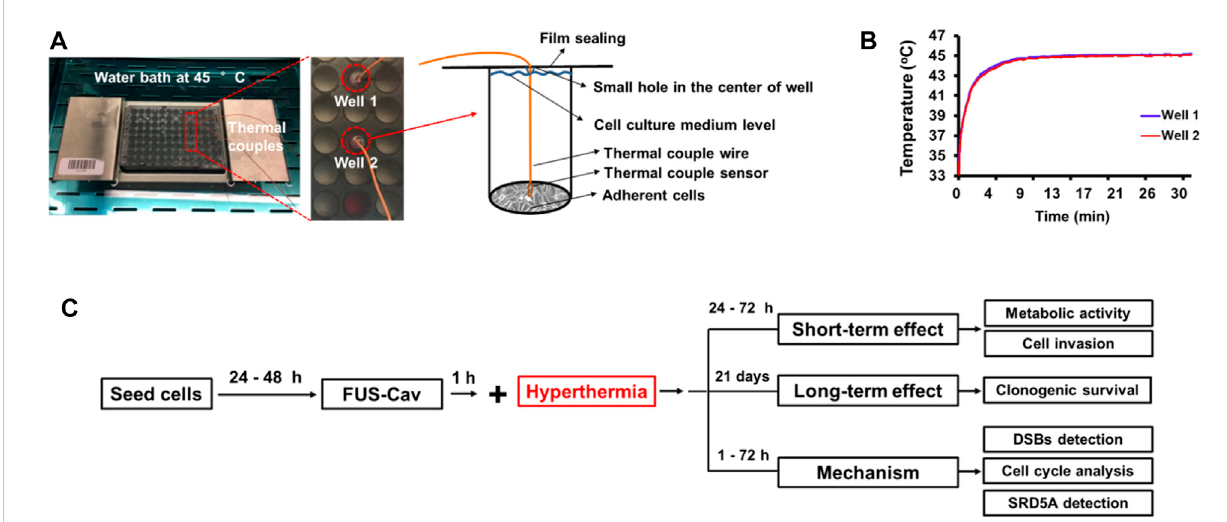
FIGURE 2 Experimental setup of water bath hyperthermia with 96-well plate at 45 ° C. (A) The real-time temperatures in two reference wells were measured with inserted thermal couples close to monolayer cells. (B) Temperature curves in two reference wells. (C) The timeline of the combined treatment and biological experimentation is depicted in the fl ow chart for the experimental